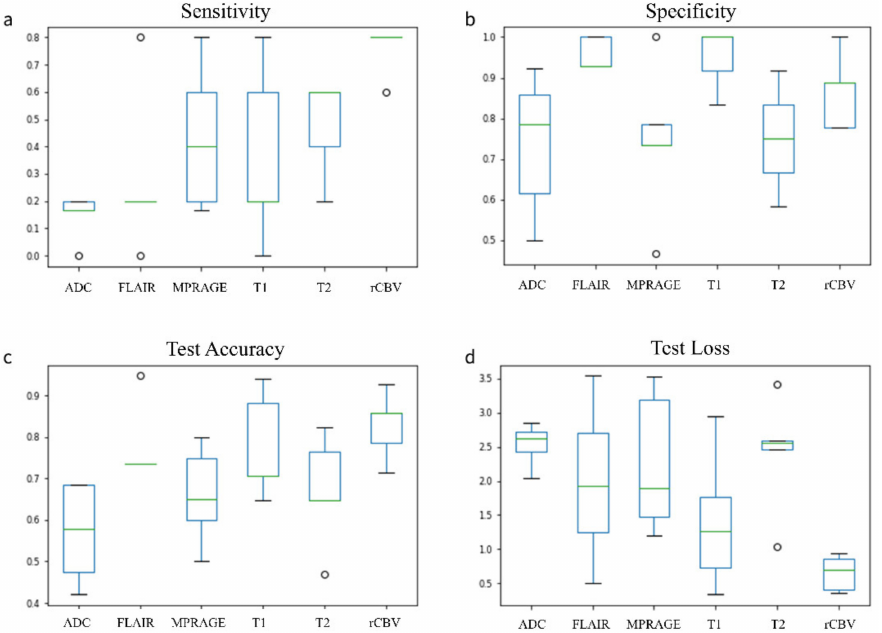
Figure 4. Boxplot on k-fold cross validation (k = 5) for sensitivity ( a ), specificity ( b ), test accuracy ( c ) and test loss ( d ) with all MRI sequences.